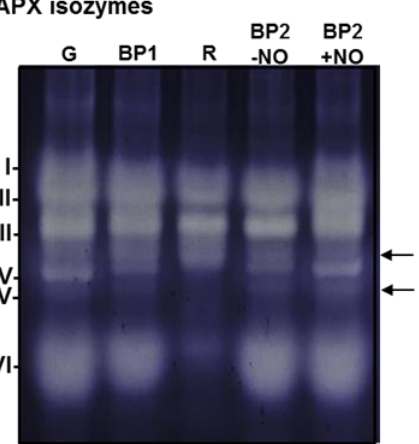
Figure 5. Ascorbate peroxidase (APX) isozymes in samples of sweet pepper fruits at different stages of ripening. Samples correspond to immature green (G), breaking point 1 (BP1), ripe red (R), and breaking point 2 with and without NO treatment (BP2 + NO and BP2 − NO, respectively). Protein samples (30 µg per lane) were separated by non-denaturing polyacrylamide gel electrophoresis (PAGE; 10% acrylamide), and activity was detected by the nitro blue tetrazolium (NBT)-reducing method. APX isozymes were labeled I – VI (on the left) according to their increasing electrophoretic mobility. Arrows indicate some minority bands.